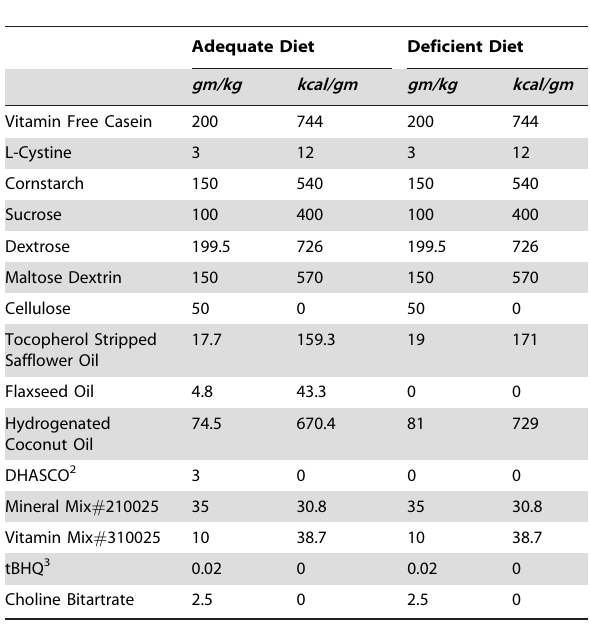
Table 1. Composition of omega-3 fatty acid adequate and omega-3 fatty acid deficient diets 1